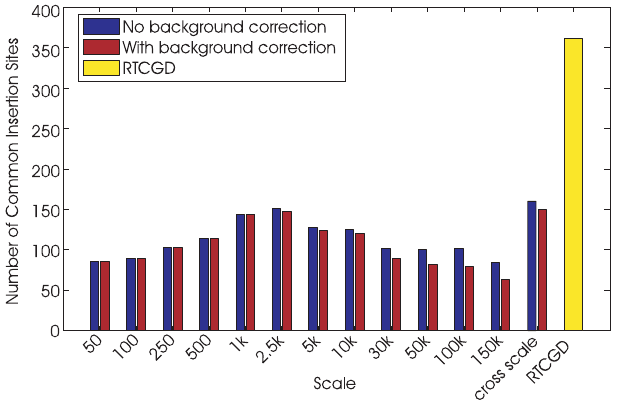
Figure 7. Number of CISs per Scale Parameter Number of CISs for Various Scale Parameters (Corrected and Uncor- rected), the csCISs, the Background-Corrected csCISs, and the CISs from the RTCGD. Background correction only has effect at larger scales.